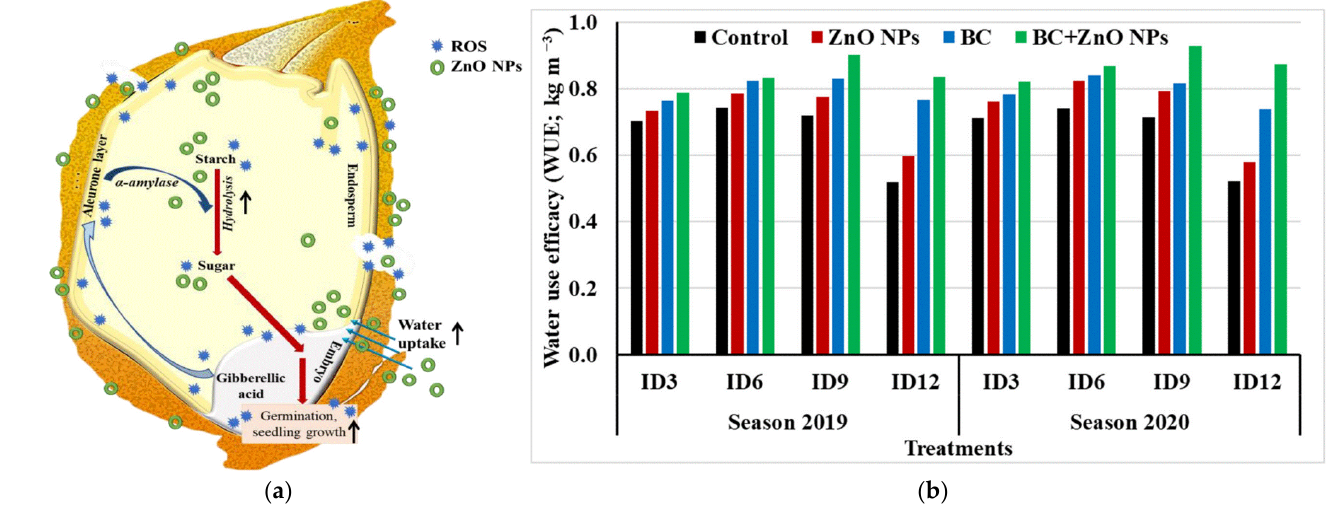
Figure 9. ( a ) Expected mechanism of ZnO-nanoparticle-induced germination in rice seeds. Reprinted with permission from Ref. [77]. 2021, Elsevier; ( b ) interaction effects between irrigation deficit and applications of biochar, ZnO NPs, and their combination treatments on water use efficacy (WUE) during the 2019 and 2020 seasons. Reprinted with permission from Ref. [79]. 2022, Multidisciplinary Digital Publishing Institute.